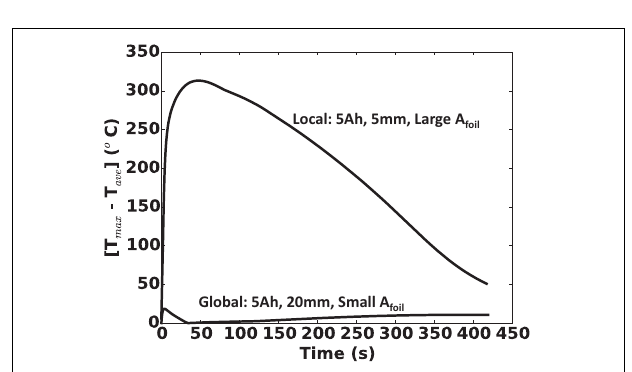
FIGURE 10 | Local temperature profiles for 5Ah cell with largest foil area and 5mm nail (top curve), and 5Ah cell with smallest foil